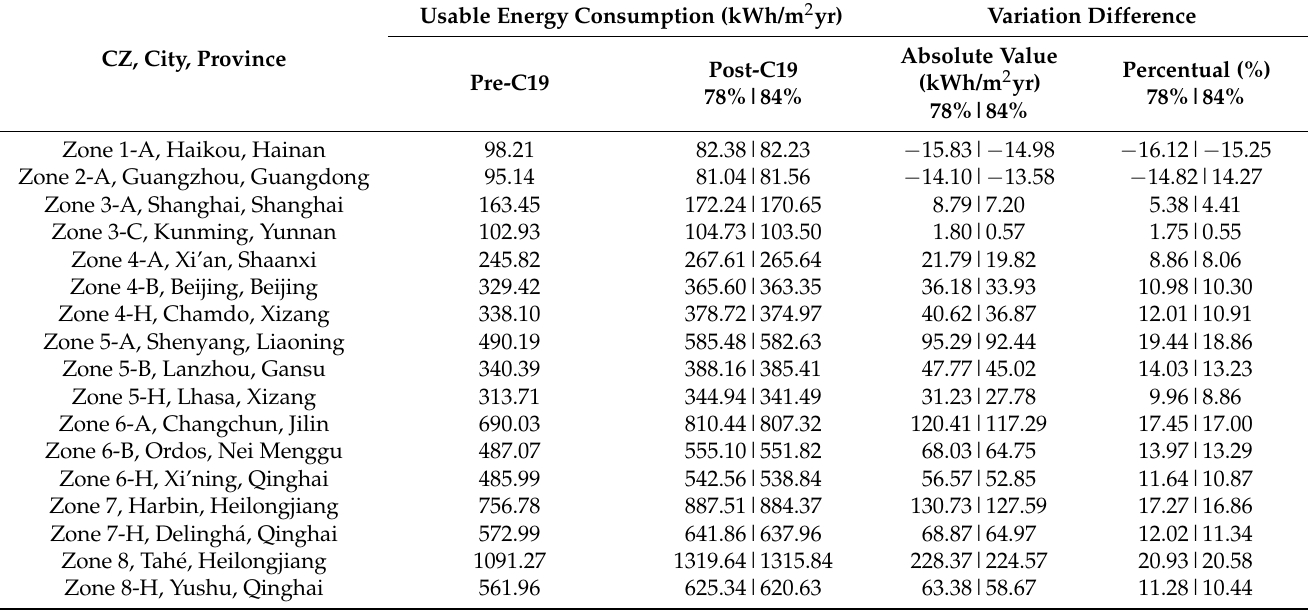
Table 10. Usable energy consumption per location in pre- and post-C19